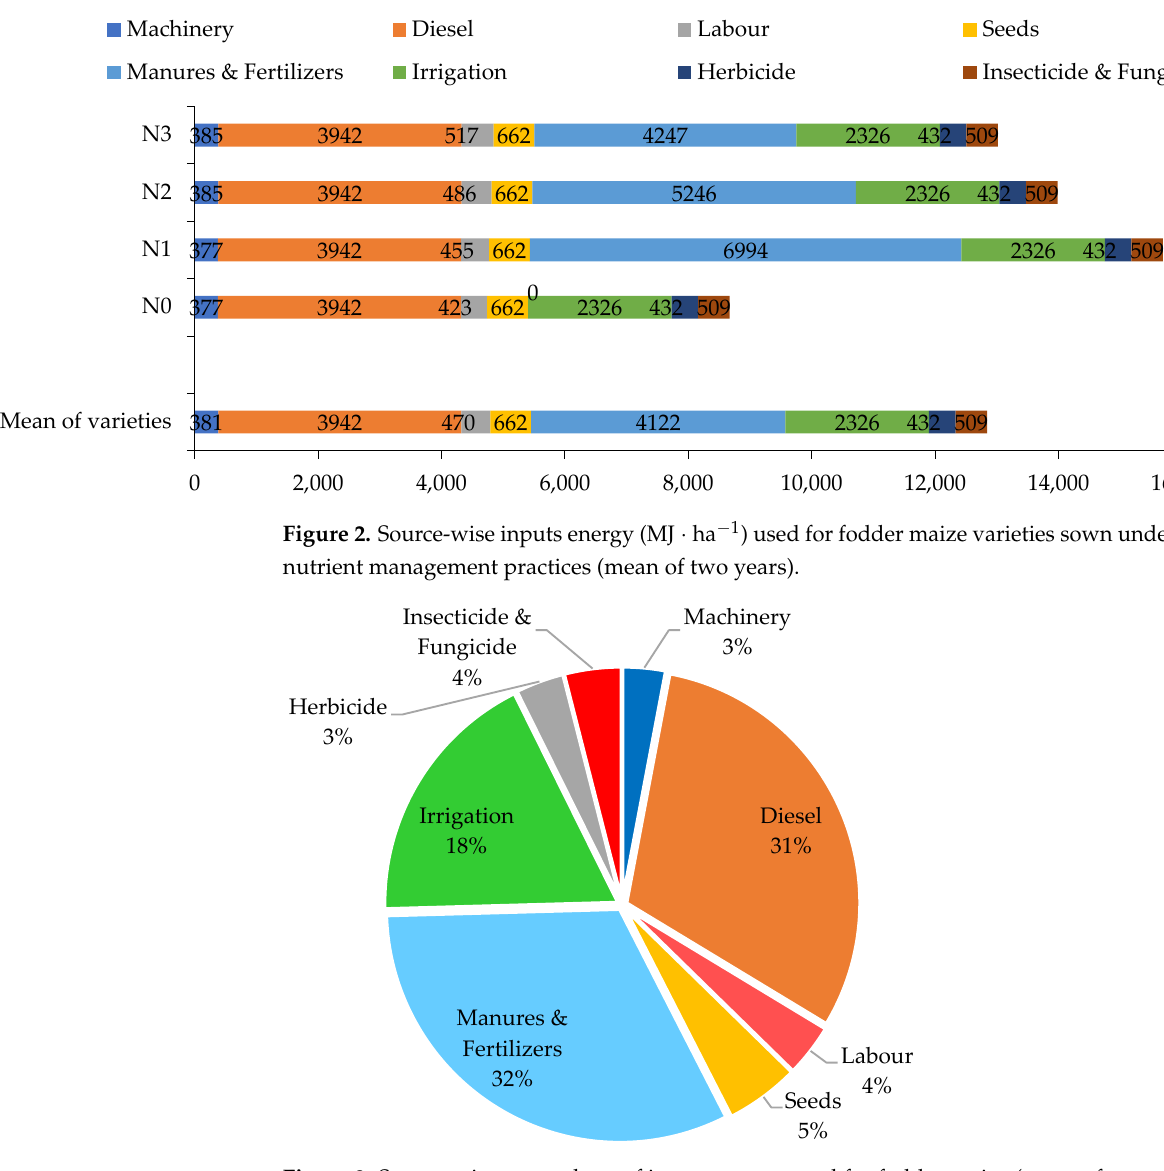
Figure 3. Source-wise mean share of inputs energy used for fodder maize (mean of two years).